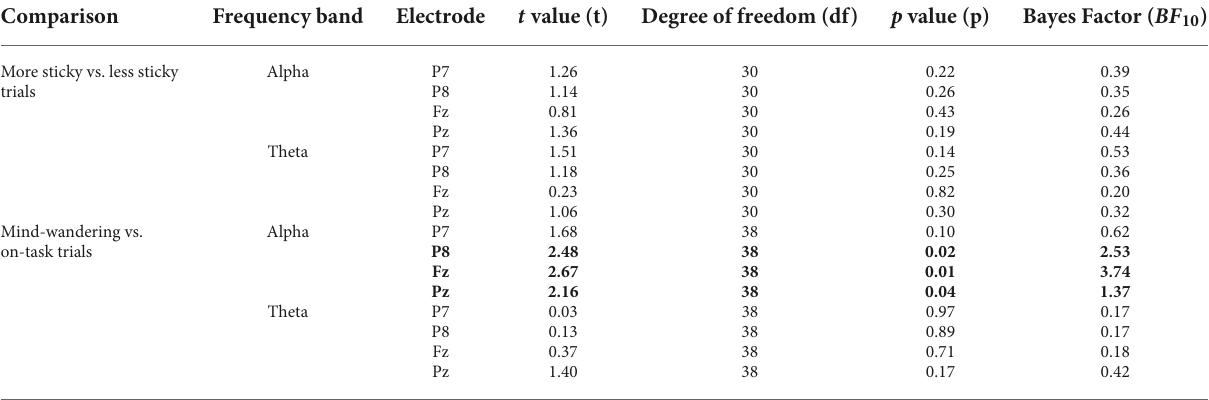
TABLE 4 Pairwise t-tests comparing oscillatory power in alpha and theta band at the P7, P8, Fz, and Pz electrodes between different groups of trials. Comparison More sticky vs. less